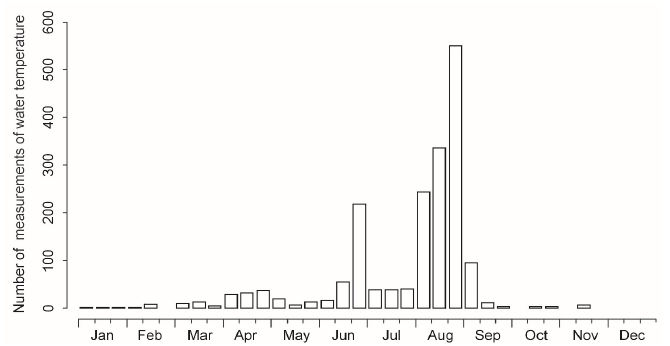
Figure 5. Number of in situ measurements of the water temperature (temperature profiles) in the 1951–1968 period in Polish